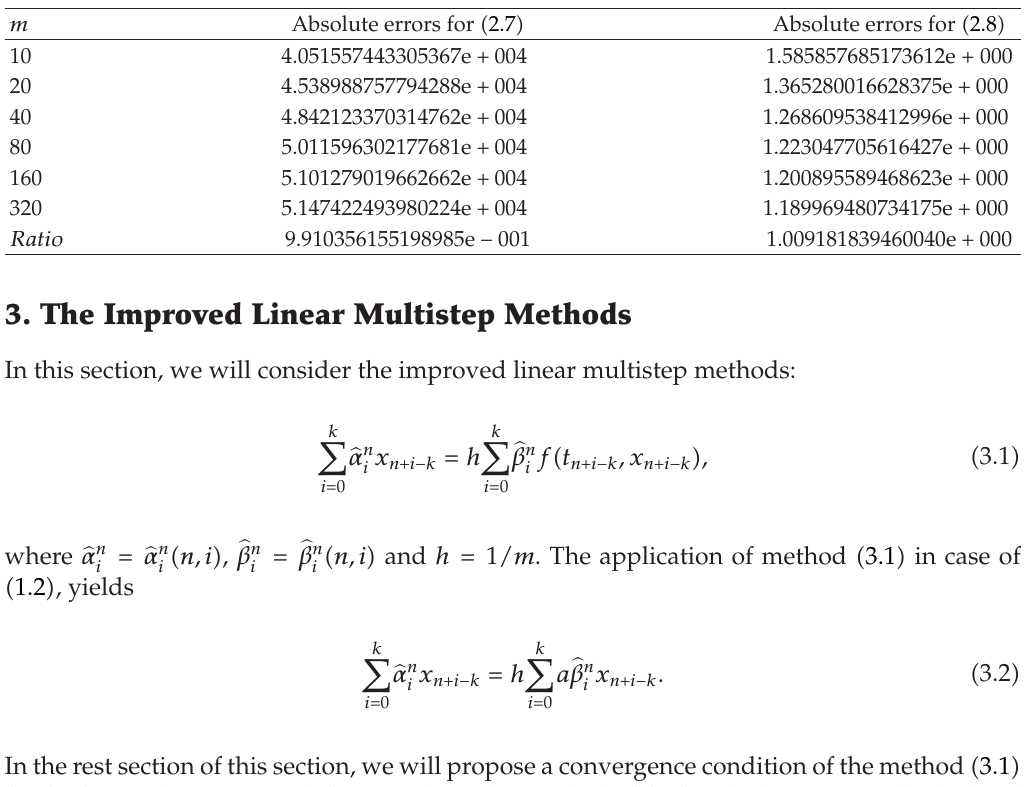
Table 3: The 2-step BDF methods for (cid:6) 2.7 (cid:7) and (cid:6) 2.8 (cid:7)